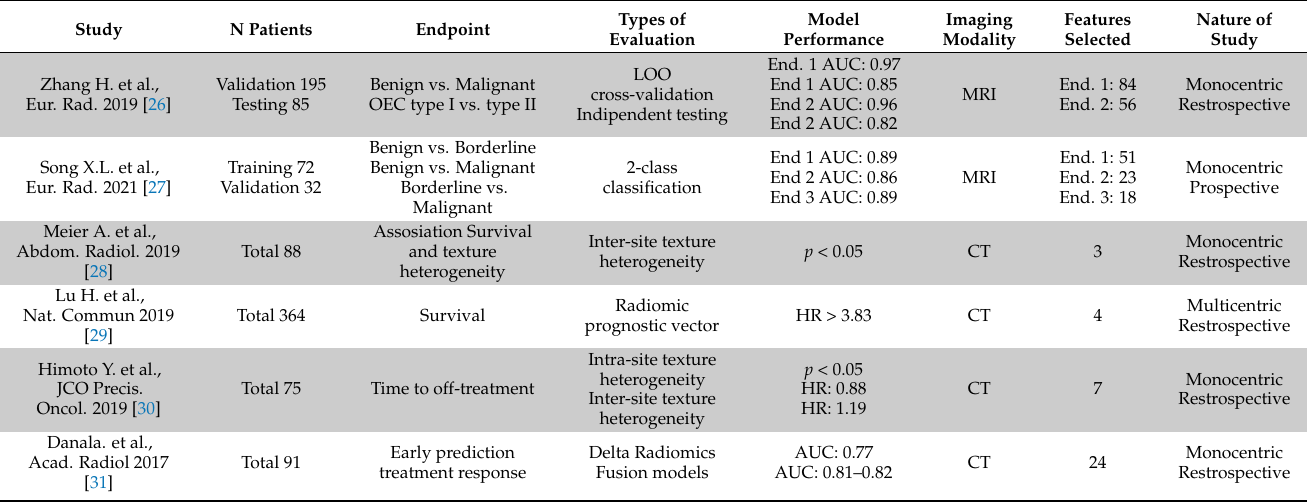
Table 2. Table summarizing the main studies regarding Radiomics applied to ovarian